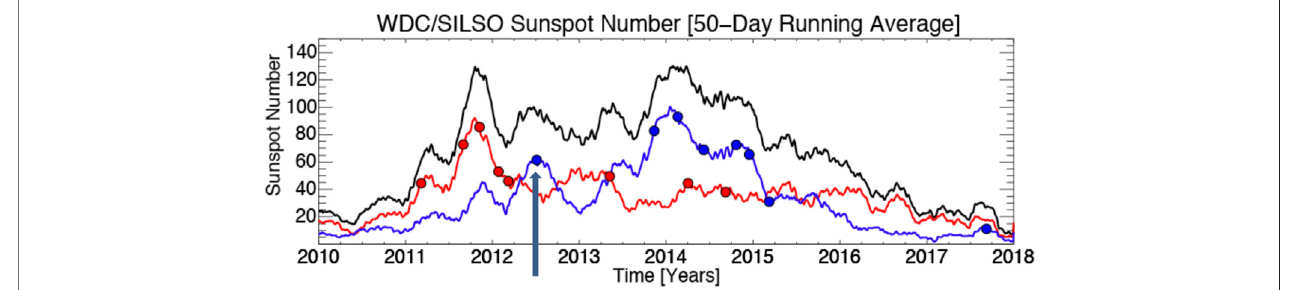
FIGURE 1 | Sunspot cycle 24 as function of time; red denotes the cycle in the North, blue in South and the black curve denotes the total cycle. The near-miss Carrington type event occurred during July 12, marked by thick black